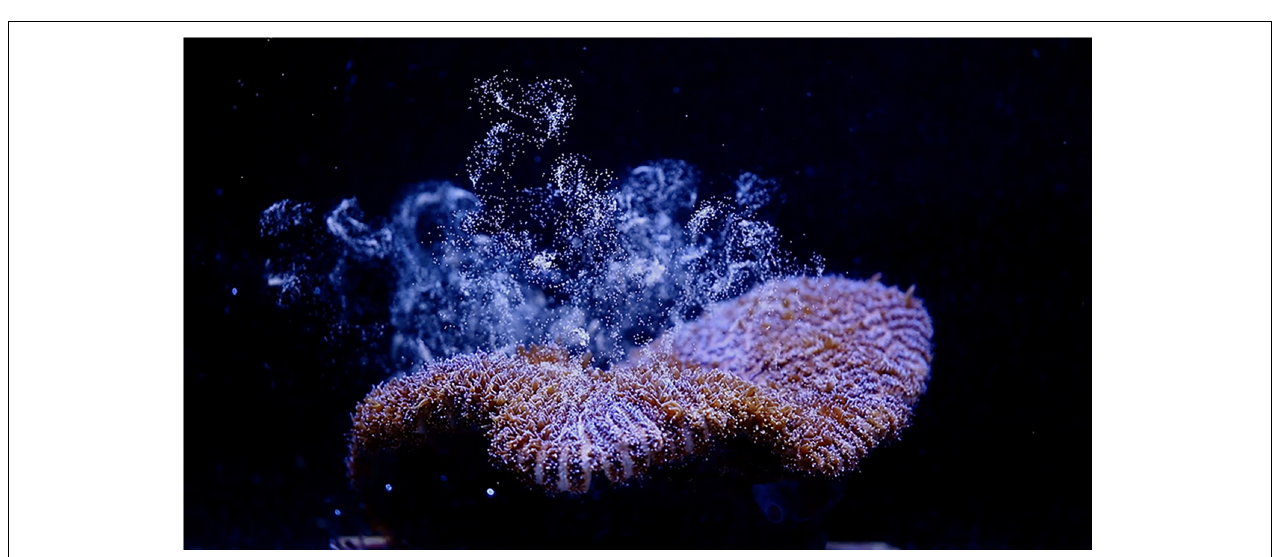
FIGURE 1 | Daily spawning observations of D. cylindrus colonies in separate controlled systems (Tank A and Tank B) during 2019 (top) and 2020 (bottom). Annual photoperiod, irradiance, lunar, and temperature cycles in the fully enclosed systems were programmed to match those in the Florida Keys and these programmed dates are noted in the top row of x -axis labels, while actual calendar date of spawning observation is noted in the bottom row of x -axis labels. Programmed and actual calendar dates align except for Tank B in 2020, when the month of March was removed from the annual cycle.